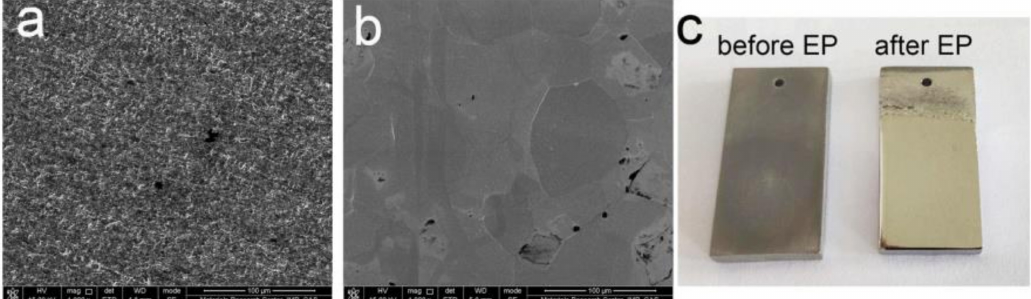
Figure 18. Surface micrographs of Nb samples: before ( a ) and after ( b ) electropolishing; optical picture ( c ). (Reprinted with permission from ref. [70]; Copyright 2021